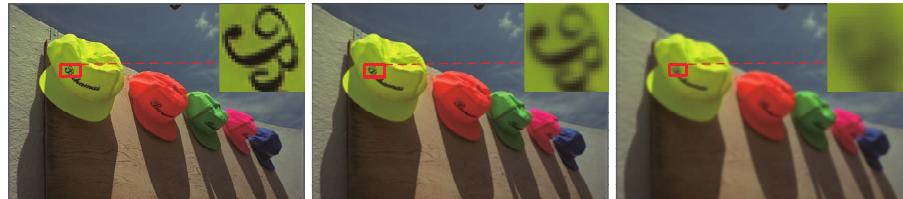
Figure 1. A sharp image ( left ) possesses conspicuous quality decline than a blurred image ( middle ) after blur processing ( right